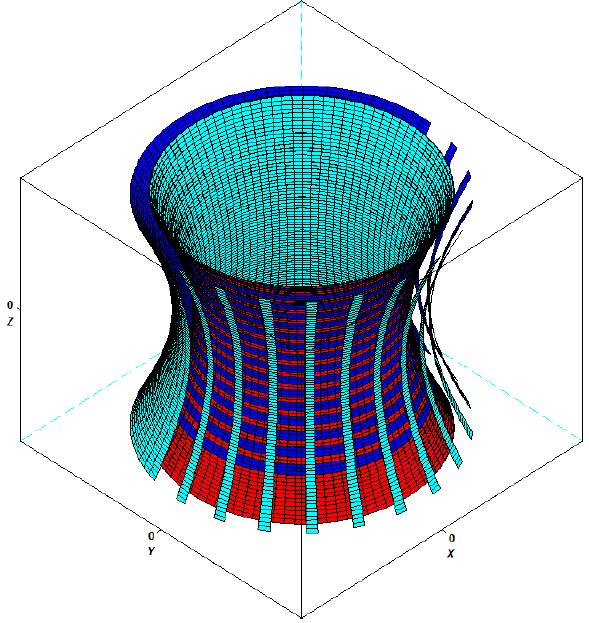
Figure 7: Wall model of a cooling tower